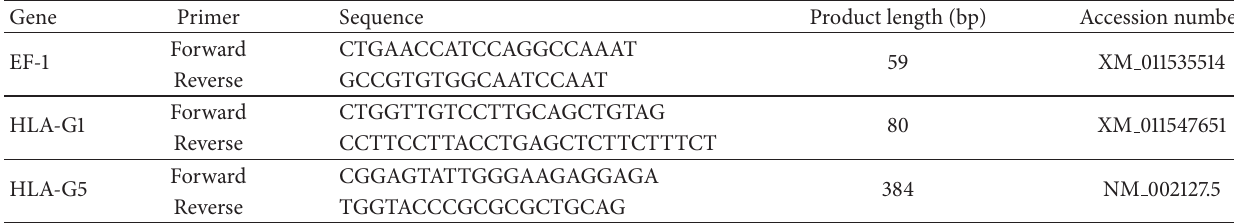
Table 2: Primer sequence of HLA-G1, -G5 isoforms and elongation factor